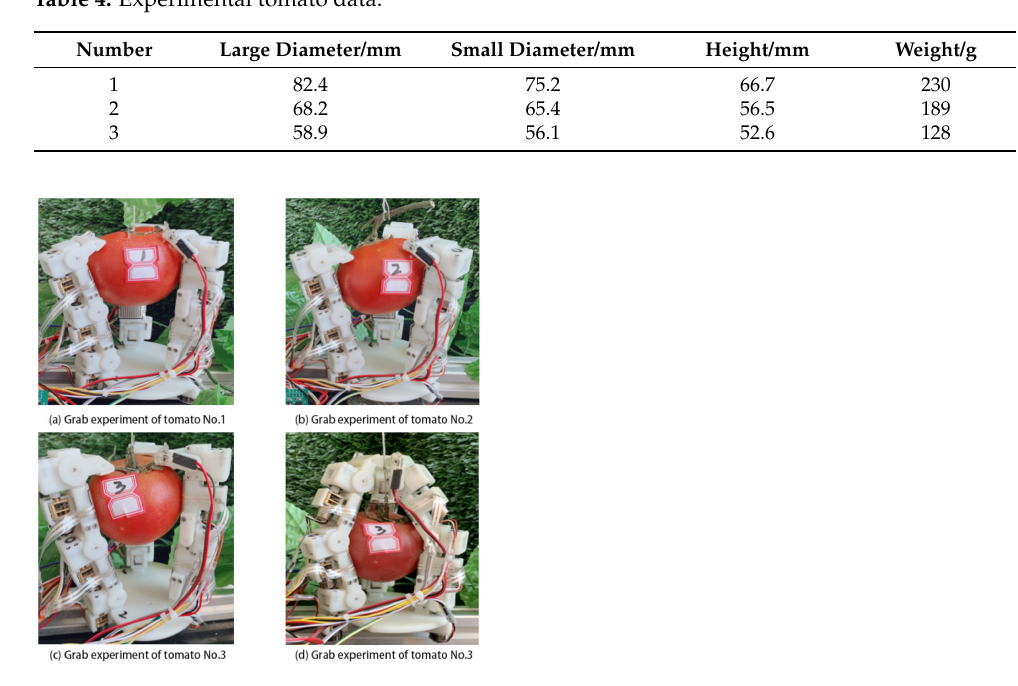
Figure 24. End-effector test